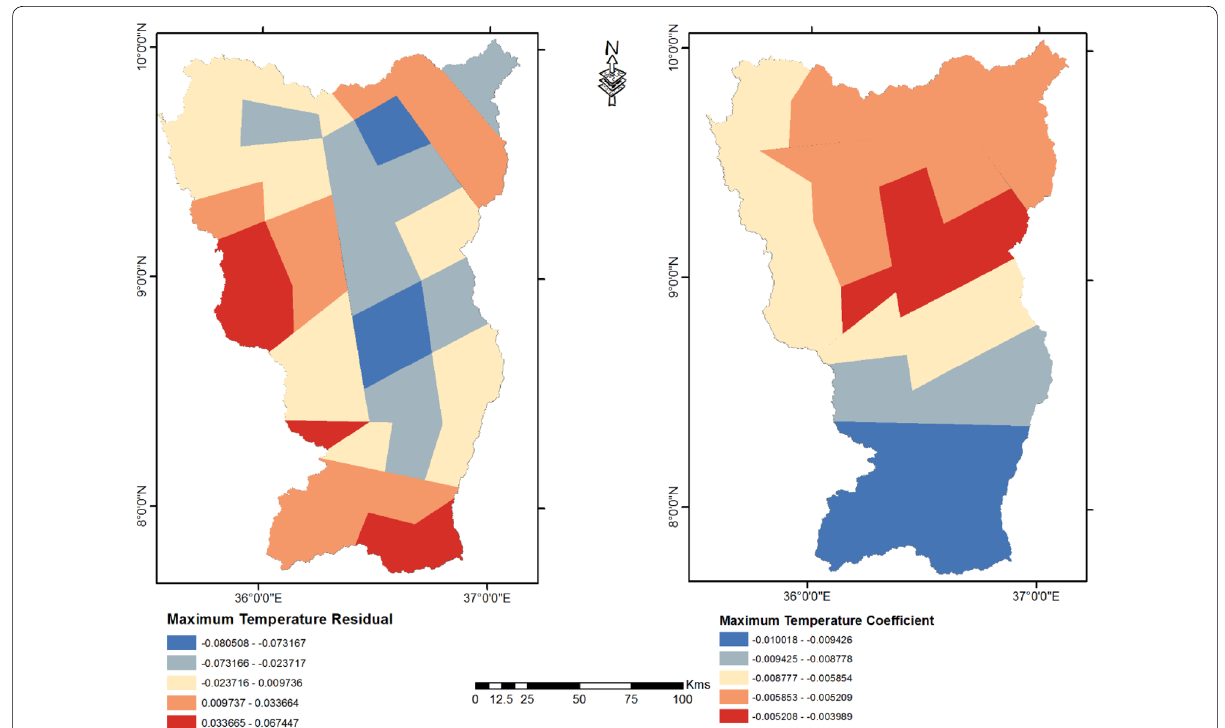
Fig. 8 GWR model residuals (right) and coefficients (left) for NDVI-maximum